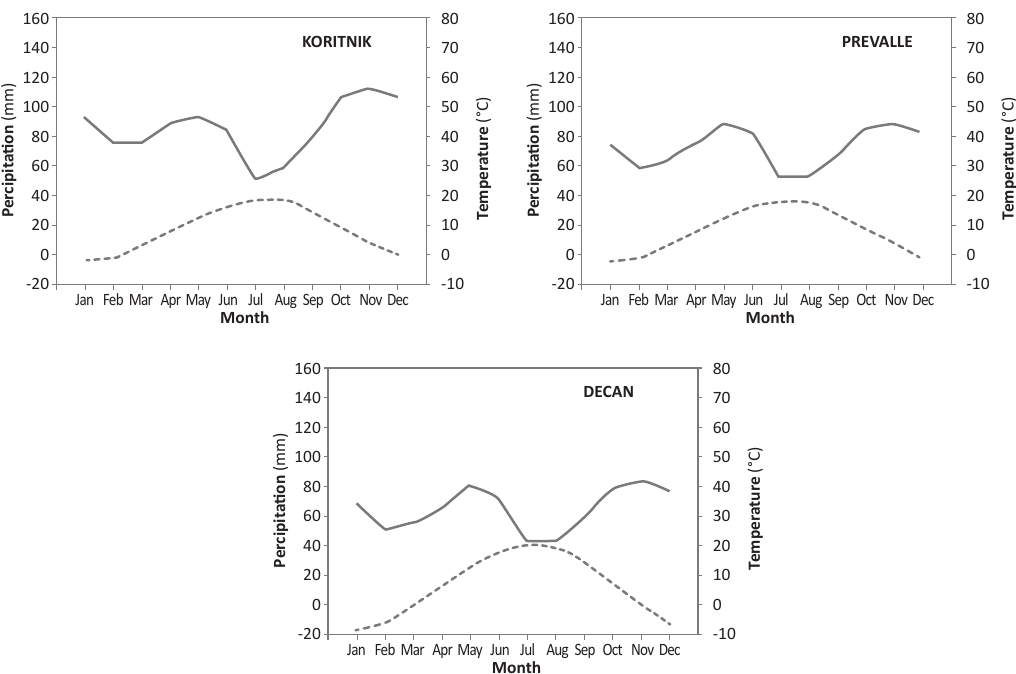
figURe 2. Climatic diagrams of the studied sites based on the CRU TS 3.22 data. Dashed line shows temperature, while solid line precipitation